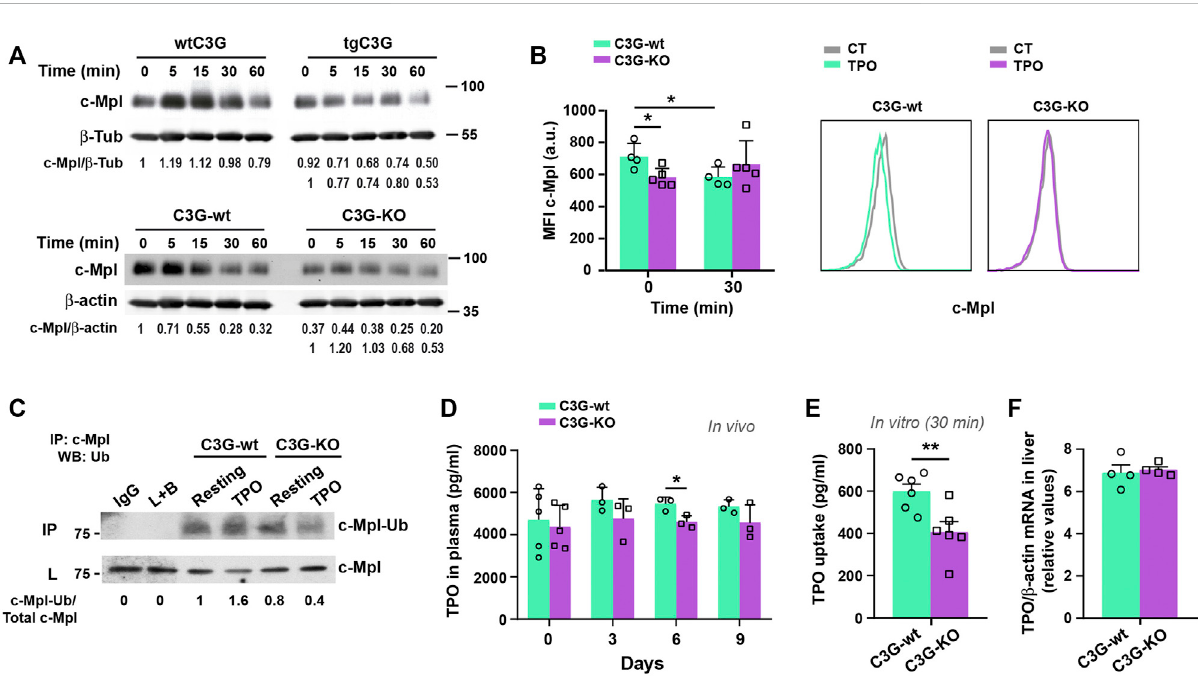
FIGURE 5 C3Gregulatesc-Mpl internalizationanddegradation. (A) Plateletsfromtheindicatedgenotypeswerestimulatedwith25 ng/ml(tgC3Glineage) or 100 ng/ml (C3G-KO lineage)TPO for the indicated times and c-Mpl and β -tubulin ( β -Tub) or β -actin detected by western blot. Values are relative to β -tubulinor β -actin expressionand werenormalized against untreated-wild-typeplatelets or against untreated platelets of eachgenotype(lower line). (B) Platelets of C3G-KO and control mice were treated 30 min with TPO and stained for c-Mpl surface expression with anti-c-Mpl (AMM2 clone) + anti-rat-Cy5 (Mean ± SD). Representative fl ow cytometry plots of c-Mpl internalization in each genotype are shown. CT: non- stimulated control. (C) Lysates from C3G-KO and C3G-wt platelets, resting or treated with TPO (100 ng/ml, 5 min were immunoprecipitated with anti-c-Mpl antibody and the levels of ubiquitinated-c-Mpl determined by western blot with anti-ubiquitin antibodies. IP: immunoprecipitation, WB: western blot. L: total cell lysates. IgG and lysate + agarose beads (L+B) were used as negative controls. Values are relative to those innon-stimulated C3G-KO platelets and were normalized to total c-Mpl. (D) C3G-KO and C3G-wt mice were injected with 0.5 μ g TPO in 100 μ l PBS. TPO was measured in plasma by ELISA at the indicated times (Mean ± SD). (E) C3G-KO and C3G-wt platelets were stimulated with TPO (2 ng/ml) for 30 min TPO levels in supernatant were measured by ELISA and TPO uptake was calculated as follows: TPO t0 pg/ml − TPO t30 pg/ml (Mean ± SEM). (F) TPO mRNAlevelsinliversfromC3G-KOandC3G-wtmicewereanalyzedbyRT-qPCRandnormalizedto β -actin(Mean±SEM).* p < 0. 0 5,** p < 0.01.a.u, arbitrary